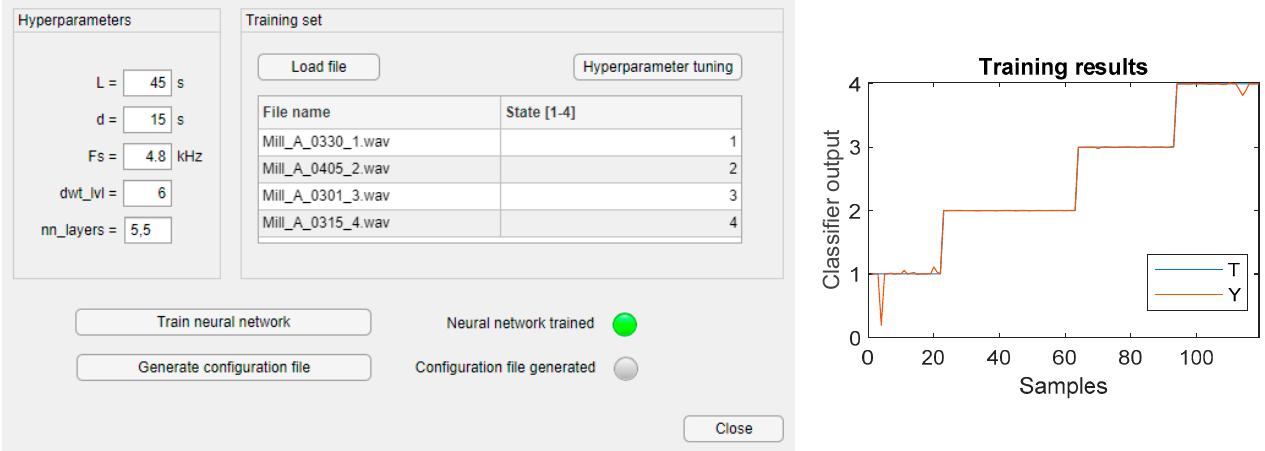
Figure 6. Configuration software with loaded training signals ( left ) and an example of training results ( right ).